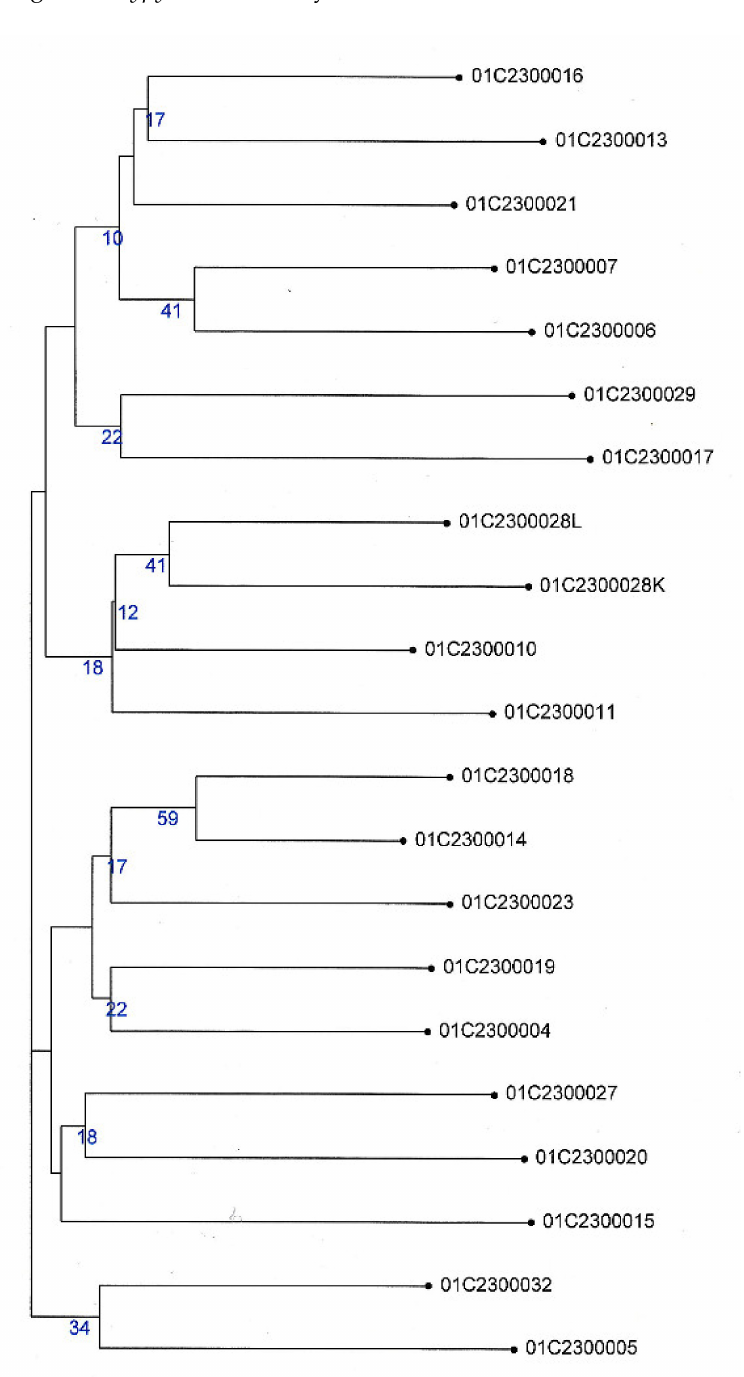
Figure 7. Dendrogram constructed by UNJ clustering method from SM dissimilarity matrix computed from SSR